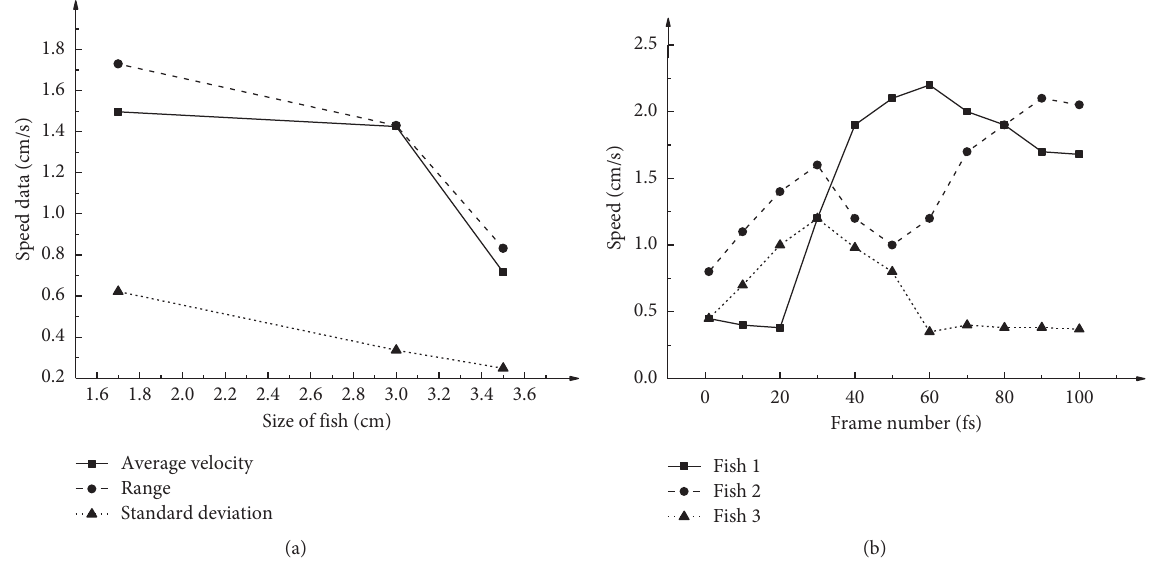
Figure 6: Swimming moving speed of medaka: (a) the statistical data of speed; (b) the speed curve.